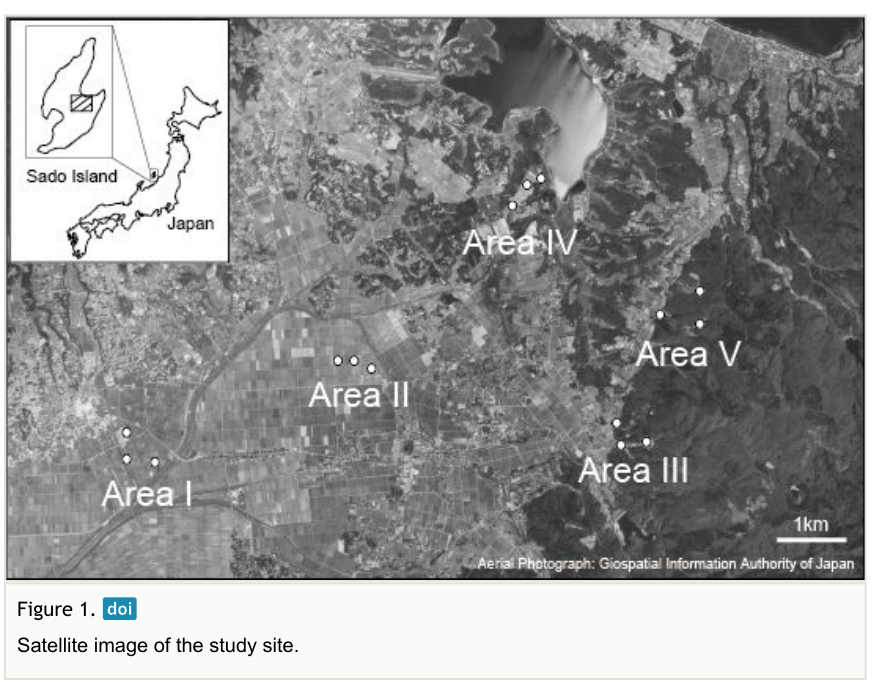
Satellite image of the study